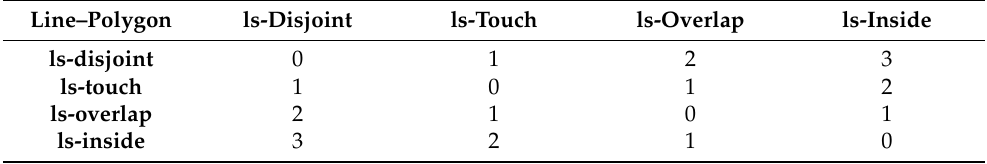
Table 6. Topological relation distance between a line segment and a polygon.